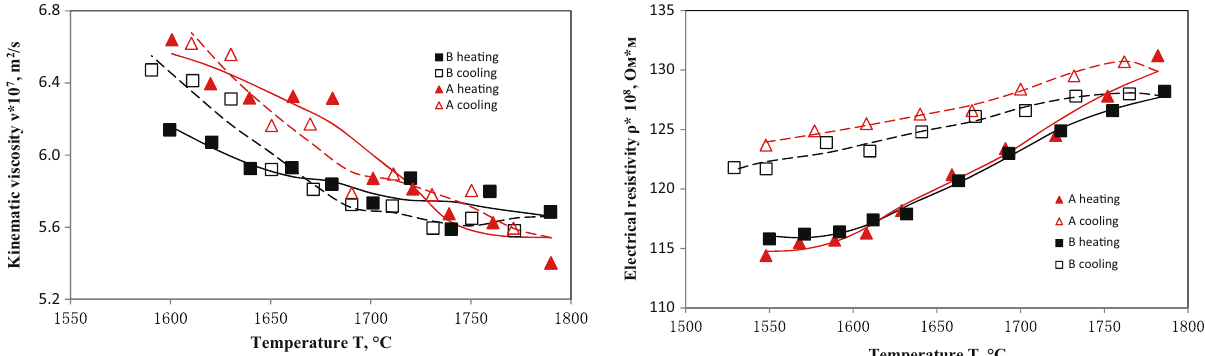
Figure 3: Changes in the kinematic viscosity of samples A and B as a function of temperature.